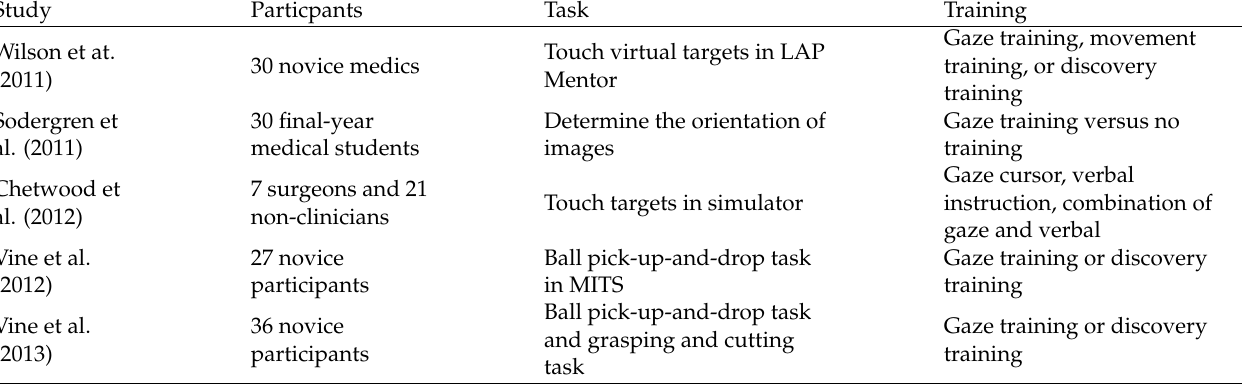
Studies examining the role of gaze training in surgery, listing the number of participants in the study, the task being examined, and the training methods being